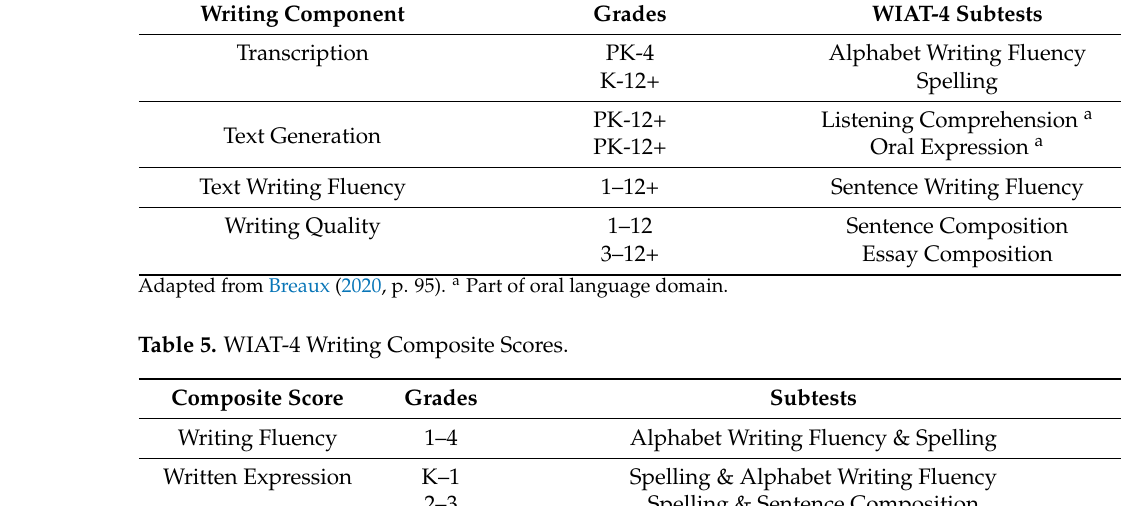
Table 4. WIAT-4 Subtest Aligned with the Simple View of Writing and its Extensions. Writing Component Transcription